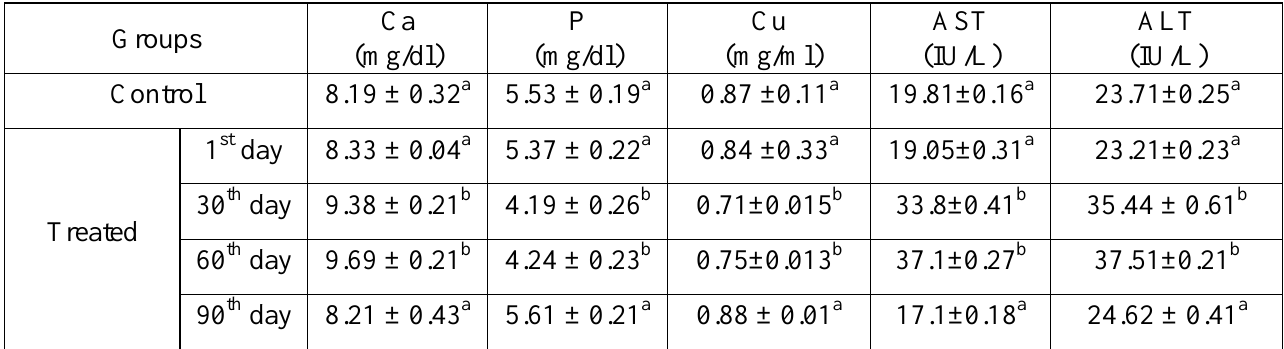
Table 3: IVM's effects on serum biochemical parameters in ewes Groups